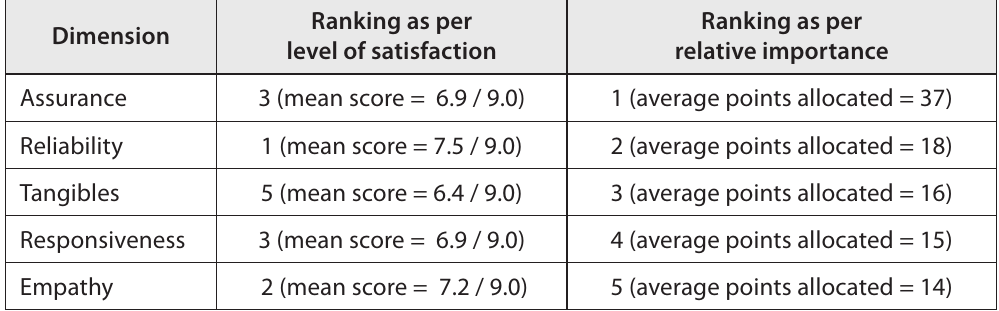
Table 3 Level of satisfaction versus relative importance of the five service quality